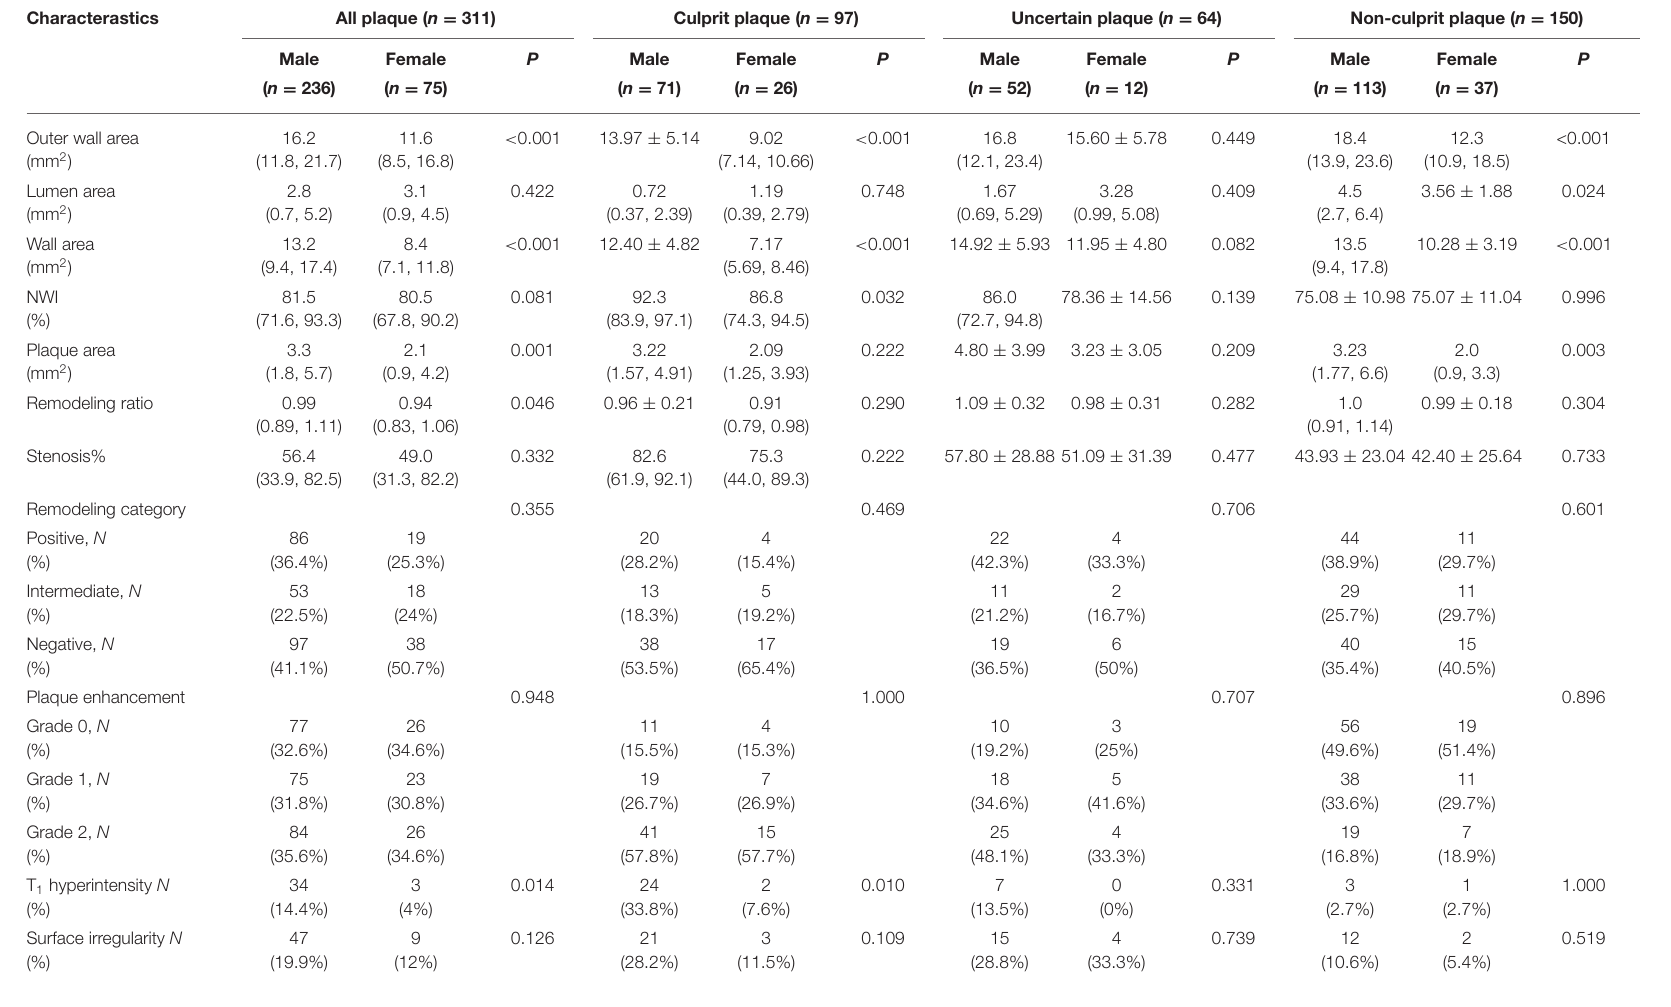
TABLE 2 | Sex differences in intracranial plaque